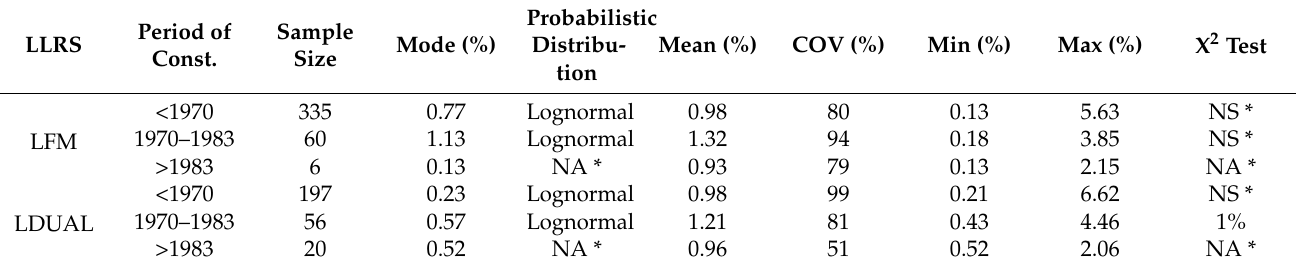
Table 10. Probabilistic distribution of RC columns (cid:48) longitudinal reinforcement ratio ( ρ tot ) in function of the lateral load resisting system (LLRS) and period of construction.